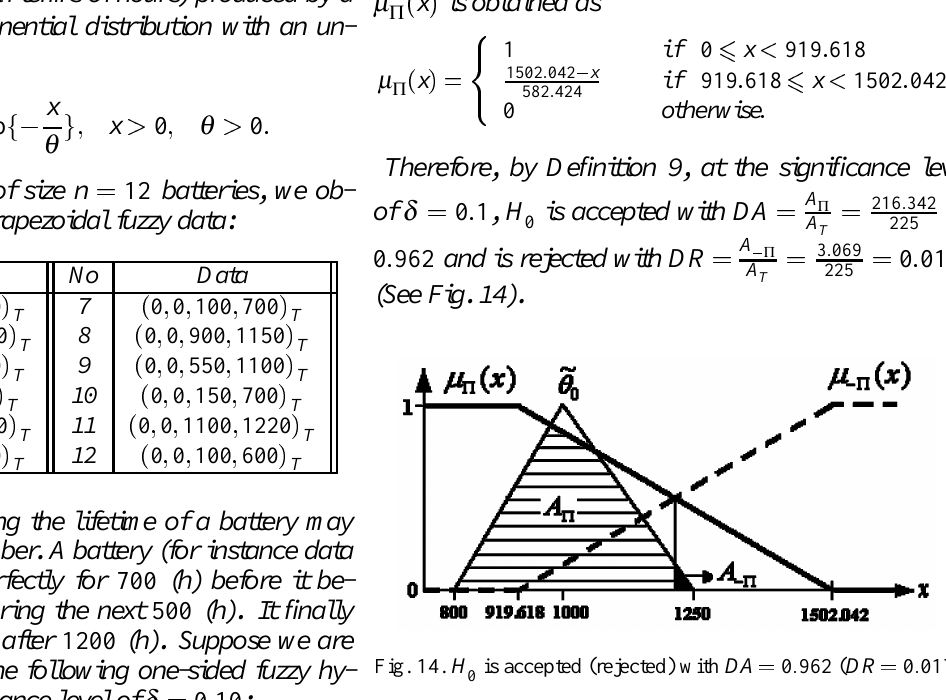
is accepted (rejected) with DA 0